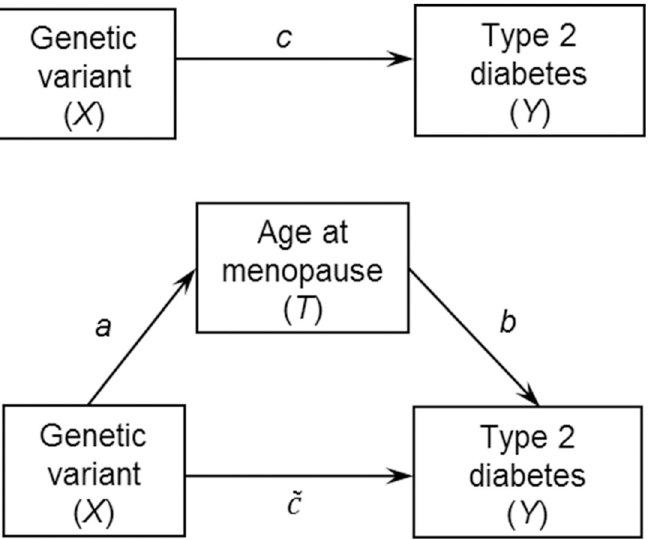
Fig 1. Conceptual model for the study of the mediating effect of a women’s age at menopause on the association between genetic variants and type 2 diabetes risk. Nodes represent the variables being analyzed in the mediation model, including genetic variant (i.e., exposure), a women’s age at menopause (i.e., mediator) and type 2 diabetes (i.e., outcome). A direct edge implies a potential direct causal effect. A pathway from one variable (genetic variant) to another (type 2 diabetes) implies a potential causal relationship through the mediator on the path (age at menopause).